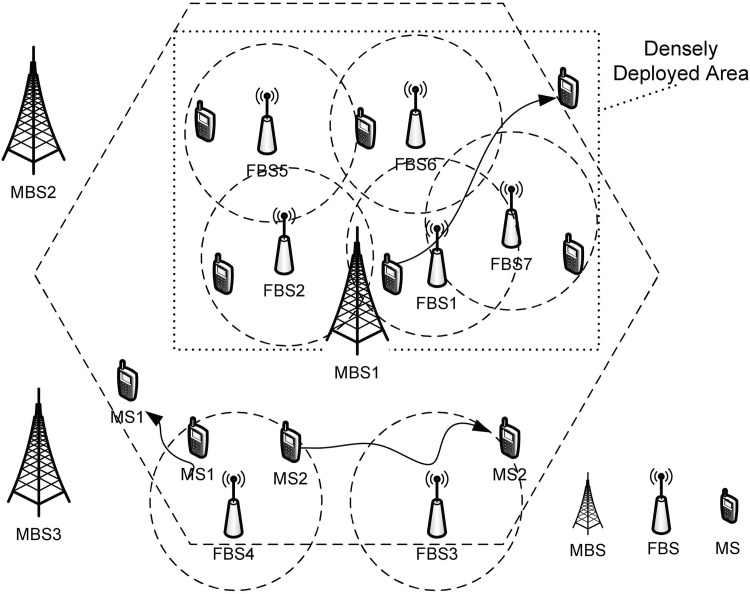
Femtocell networks.